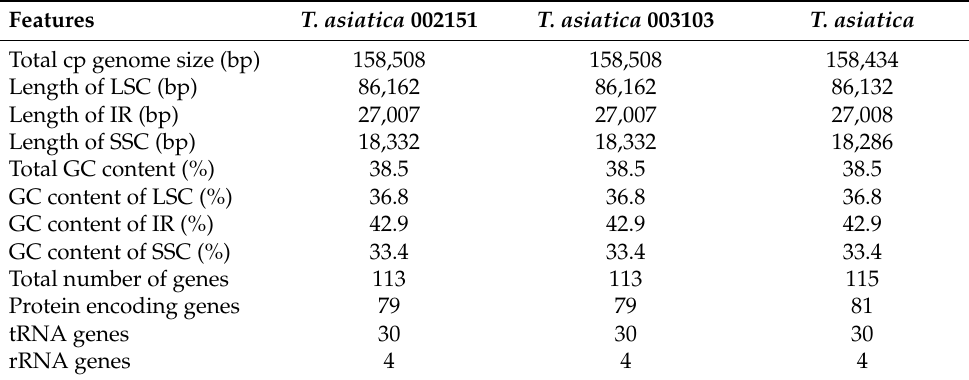
Table 2. General features of the Toddalia chloroplast genomes compared in this study.